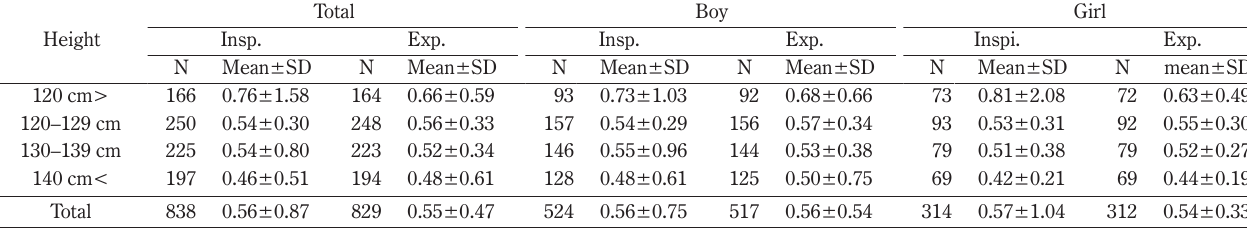
Table 4 Bilateral nasal resistance in naso-sinal morbid children and body